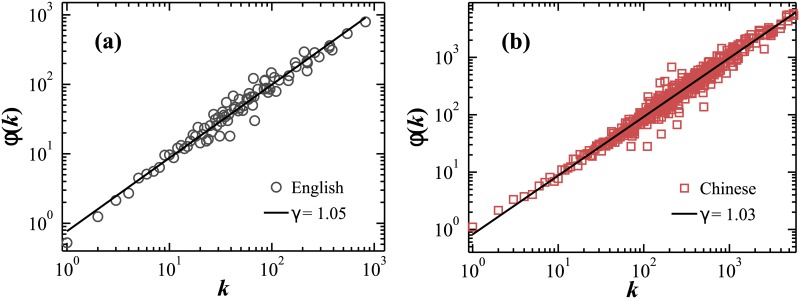
Empirical analyses of the word growth mechanism.Data show results for the first book of (a) English and (b) Chinese language listed in Table 1, revealing a scaling relation of the average number of occurrence ϕ(k) of a given word in the second half of a text, provided the frequency of occurrence of this word in the first half of the text is k. Both languages are characterized by a scaling exponent γ ≈ 1, indicating that words which appear with high frequency k in the first part of the text have also high-average occurrence in the rest of the text.